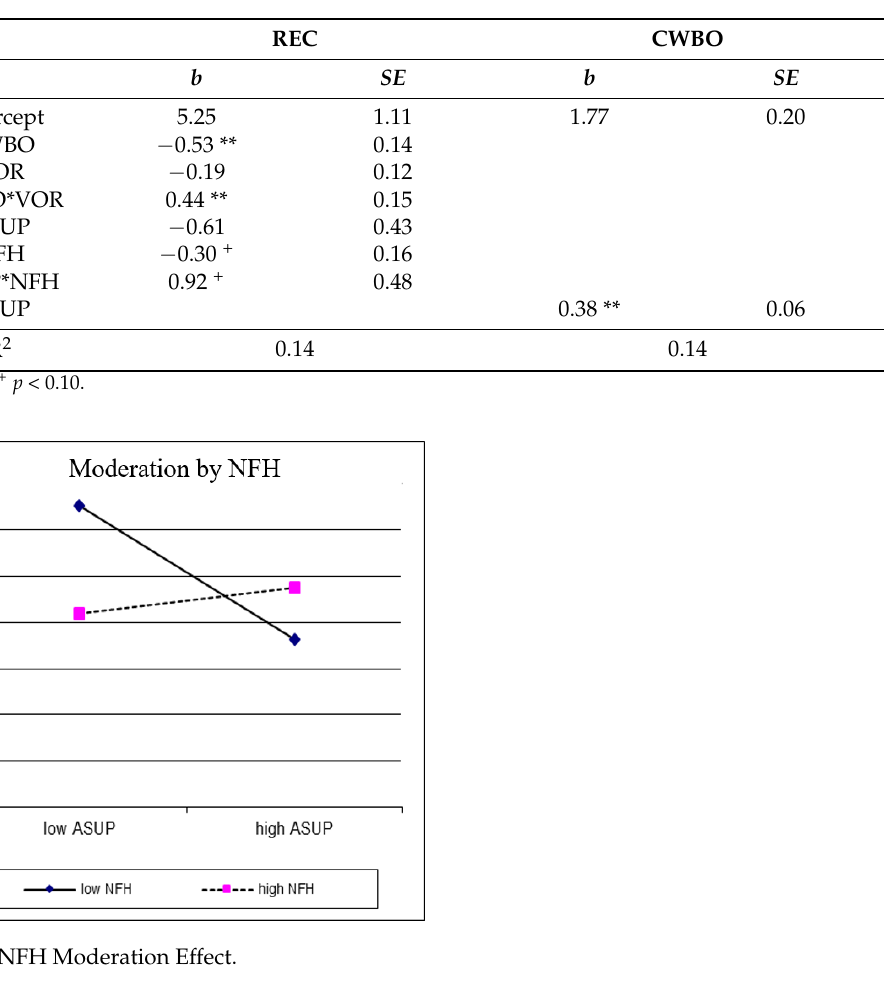
Table 6. Study 1 Results.